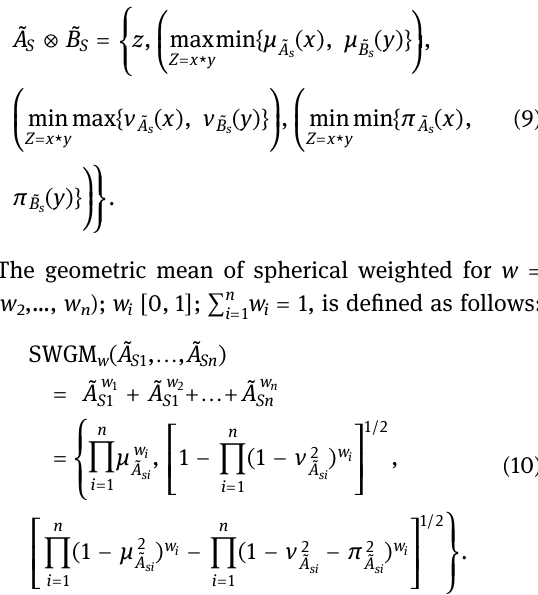
fuzzy numbers with AHP score values.